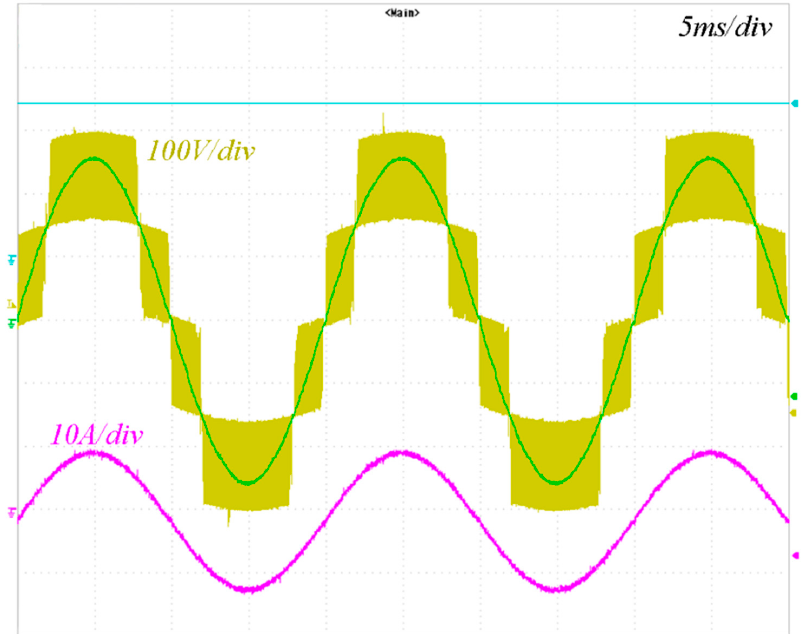
Figure 16. Grid side converter waveforms: leg-to-neutral switching voltage u a1(sw) before the output power filter (yellow track), fundamental component (green track), injected phase current (magenta track).